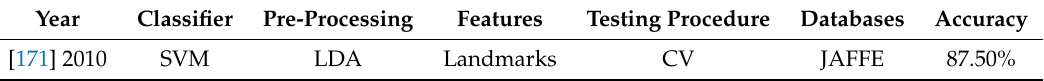
Table 5. Results of a reviewed work with a video/static multimodal approach.